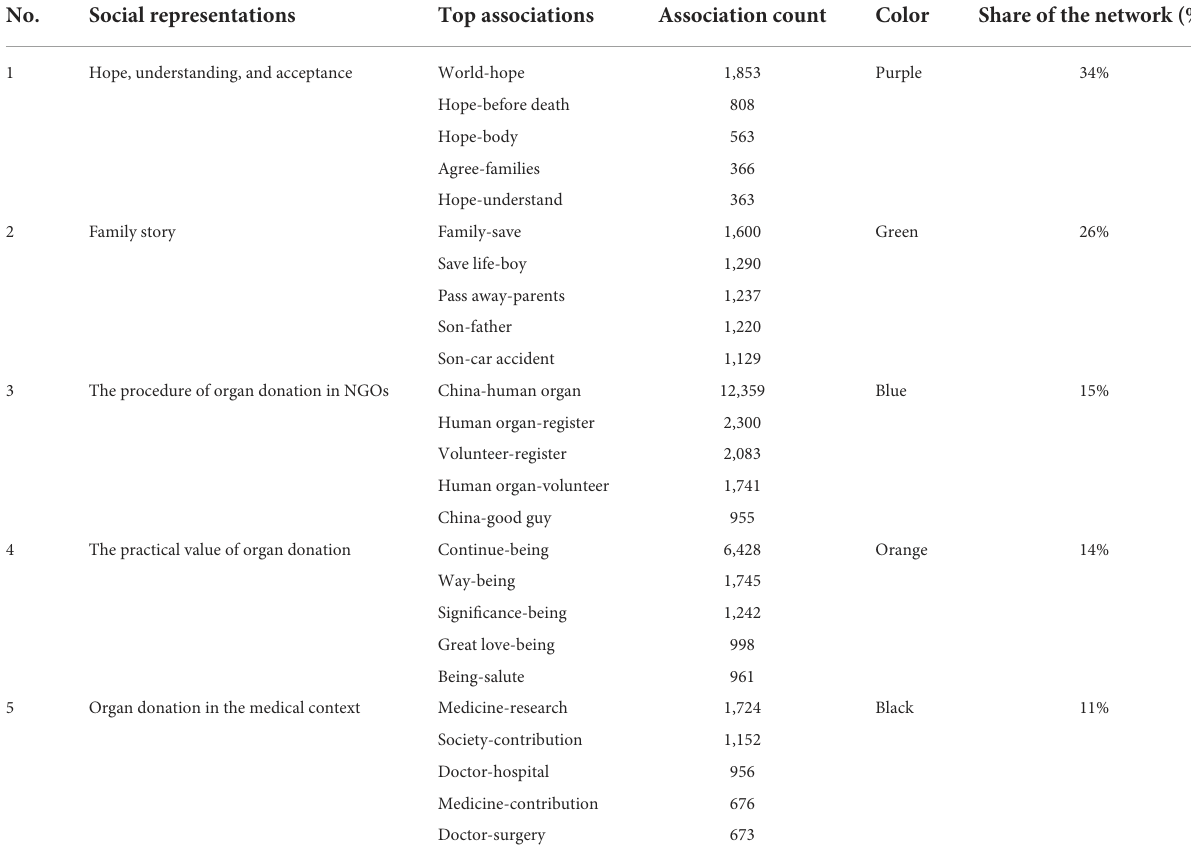
TABLE 2 Summary of social representations derived from the semantic